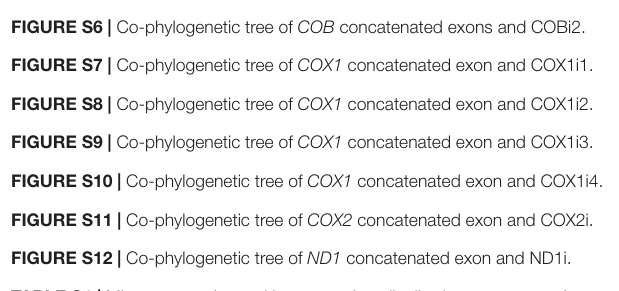
FIGURE S1 | Co-phylogenetic tree of LsRNA concatenated exons and LsRNAi1. FIGURE S2 | Co-phylogenetic tree of LsRNA concatenated exons and LsRNAi2. FIGURE S3 | Co-phylogenetic tree of LsRNA concatenated exons and LsRNAi3. FIGURE S4 | Co-phylogenetic tree of LsRNA concatenated exons and LsRNAi4.